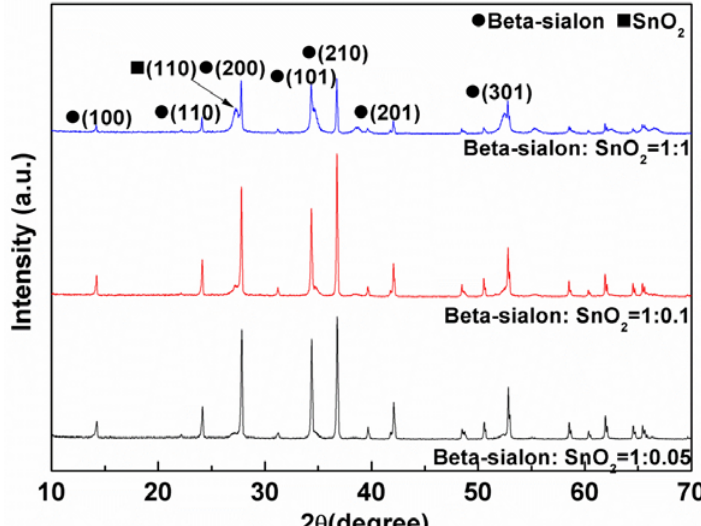
Figure 1. X-ray diffraction (XRD) patterns of the β -sialon:Eu 2+ deposits, with various mixed amounts (0.05–1 g) of the SnO , prepared by the electrophoretic deposition (EPD) process 2 at 10 s depositing